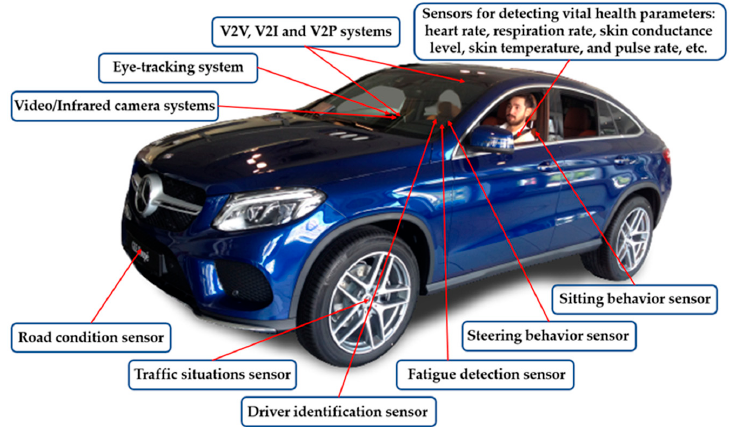
Figure 1. Futuristic in-car technologies.